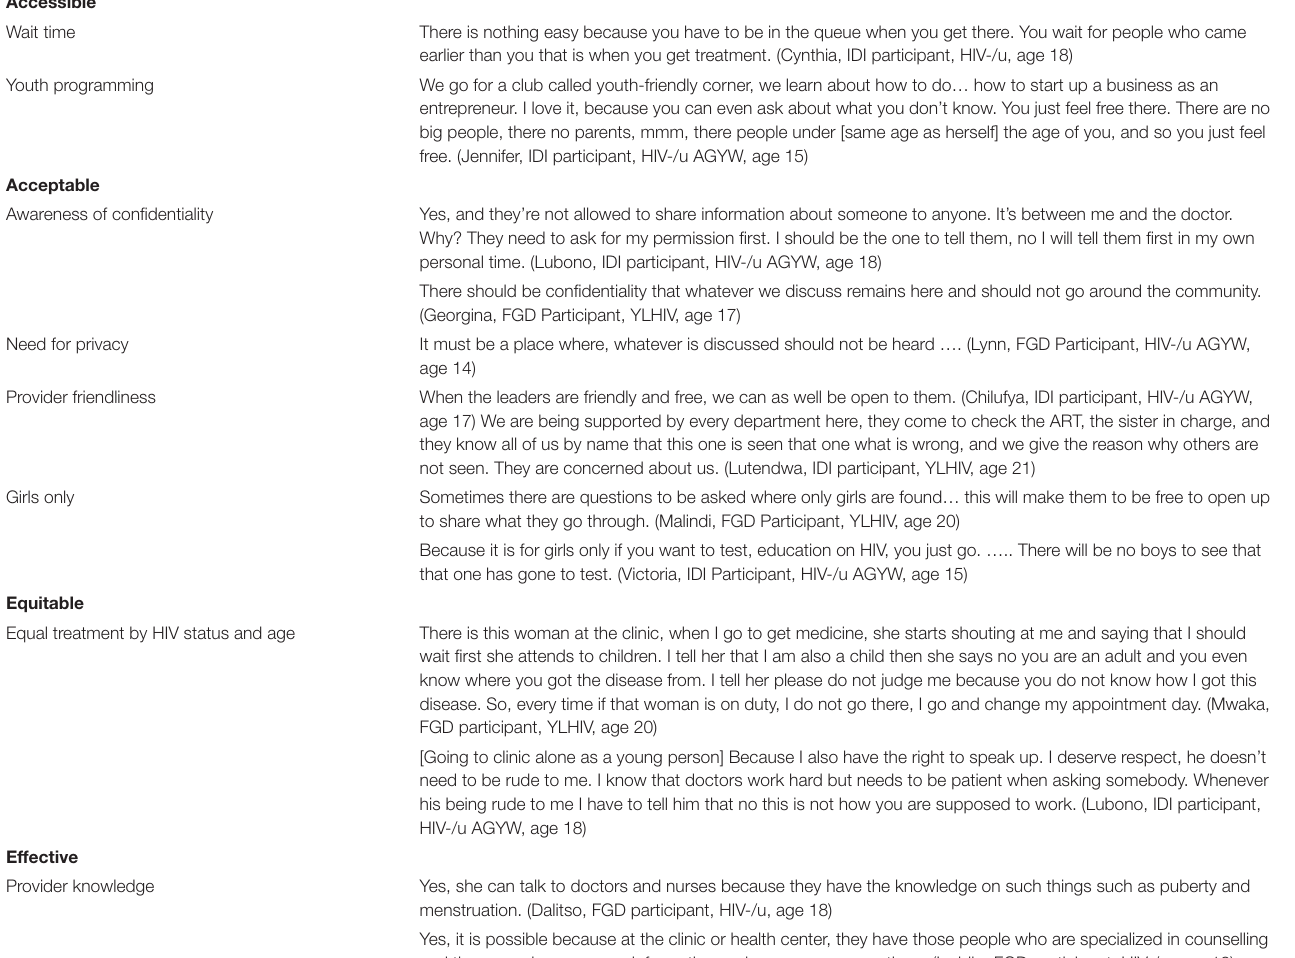
HPV vaccination and cervical cancer